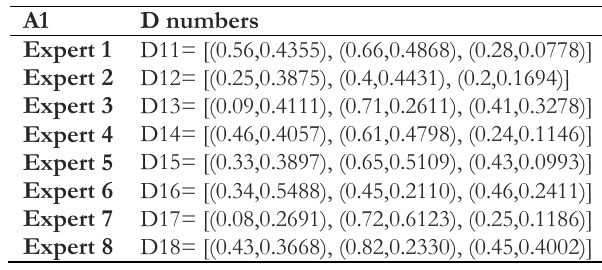
Table 2. Display of D numbers.